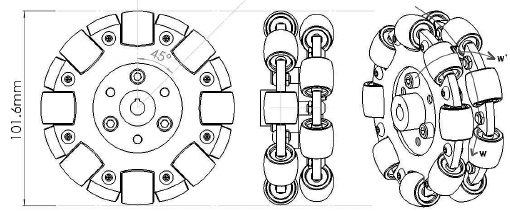
Figure 1. The structure of the mecanum wheel.